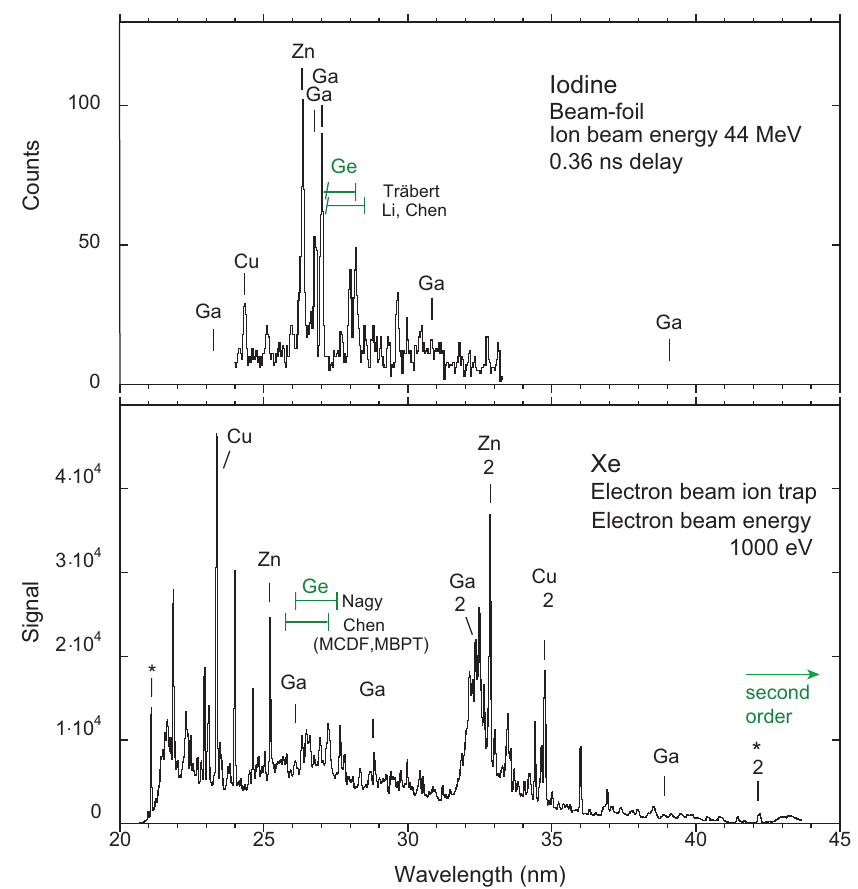
Figure 3. Delayed (Bochum) beam-foil spectrum of iodine [56] (upper panel) and (Livermore) electron beam ion trap spectrum of xenon (lower panel, [71]) in the wavelength range of the Zn-, Ga- and Ge-like ion intercombination lines. The line labels indicate isoelectronic sequences and appearance in second order of diffraction. At the long-wavelength end of the Xe spectrum, the short-wavelength range of the same spectrum appears to be shown in second order; see the line marked with an asterisk (*). The beam-foil spectrum has been measured with a scanning grazing-incidence monochromator equipped with a Channeltron detector; the electron beam ion trap measurement employed a flat-field grazing-incidence spectrograph equipped with a cryogenic CCD camera. The latter measurement required only about a tenth of the recording time of the former. The green double markers point to the two intercombination transitions in the Ge-like ions as suggested by experiment [56] or theory [57,68,72]. Neither pointer is